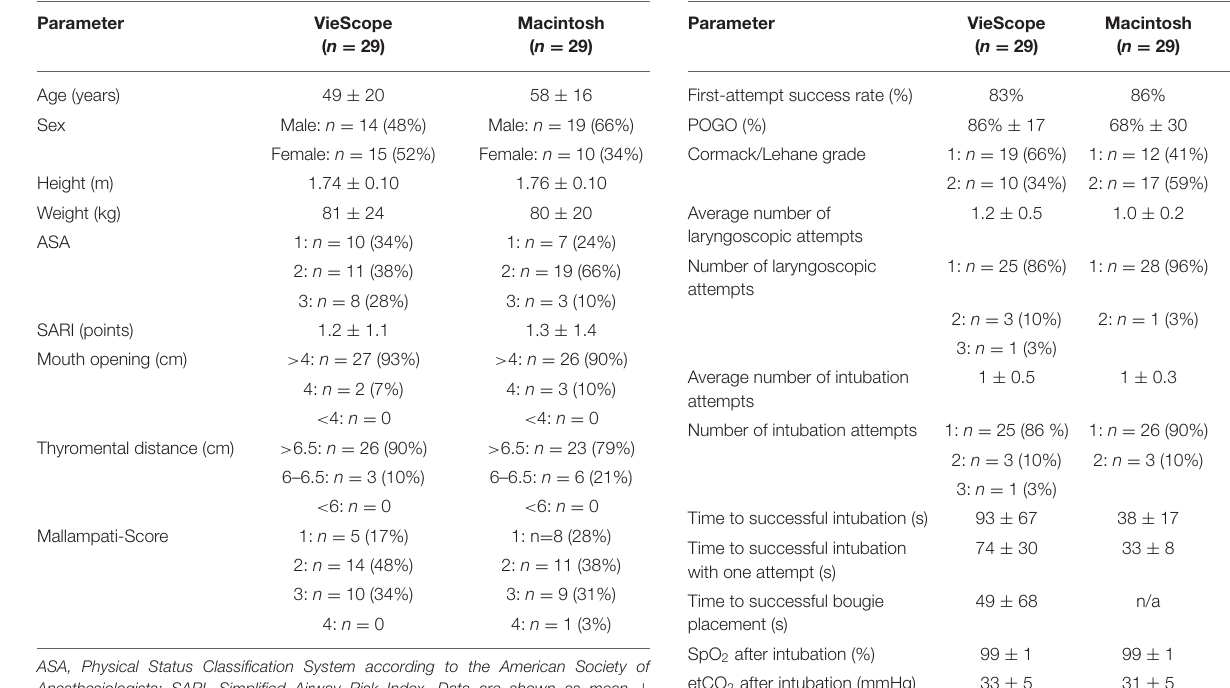
TABLE 1 | Patient characteristics. TABLE 2 | Outcome